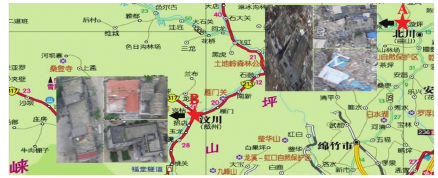
Figure 8: The application case of DDE